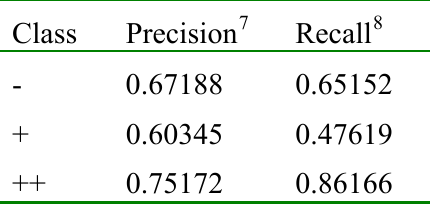
Table 3 . Precision and recall for the best-performing method on the Pax data set (recursive partitioning with bagging, using numerical representation). The method yielded an overall accuracy of 69.7% with 527